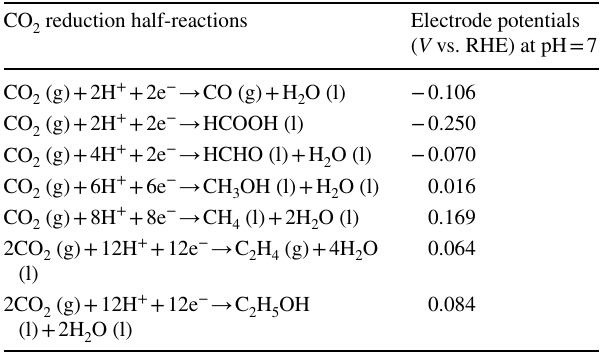
Table 1 Electrochemical potentials of several possible CO 2 reduc‑ tion reactions in aqueous solutions CO 2 reduction half‑reactions Electrode potentials ( V vs. RHE) at pH =